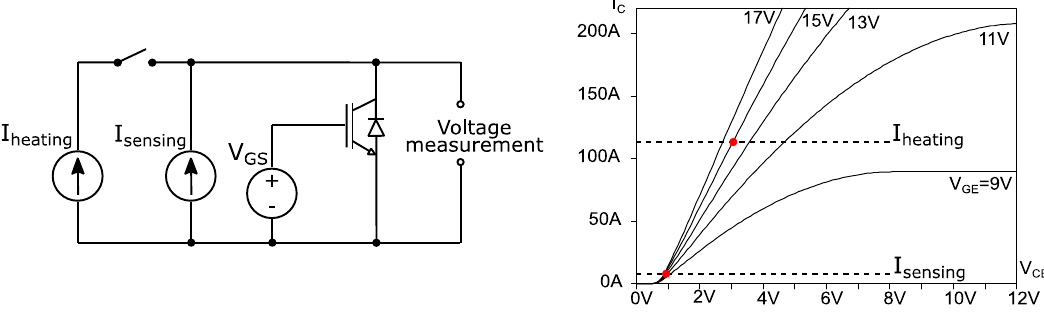
Figure 4. On-state power-cycling setup ( left ), and the set operating points at a selected V GE , I sensing and I heating combination ( right ).